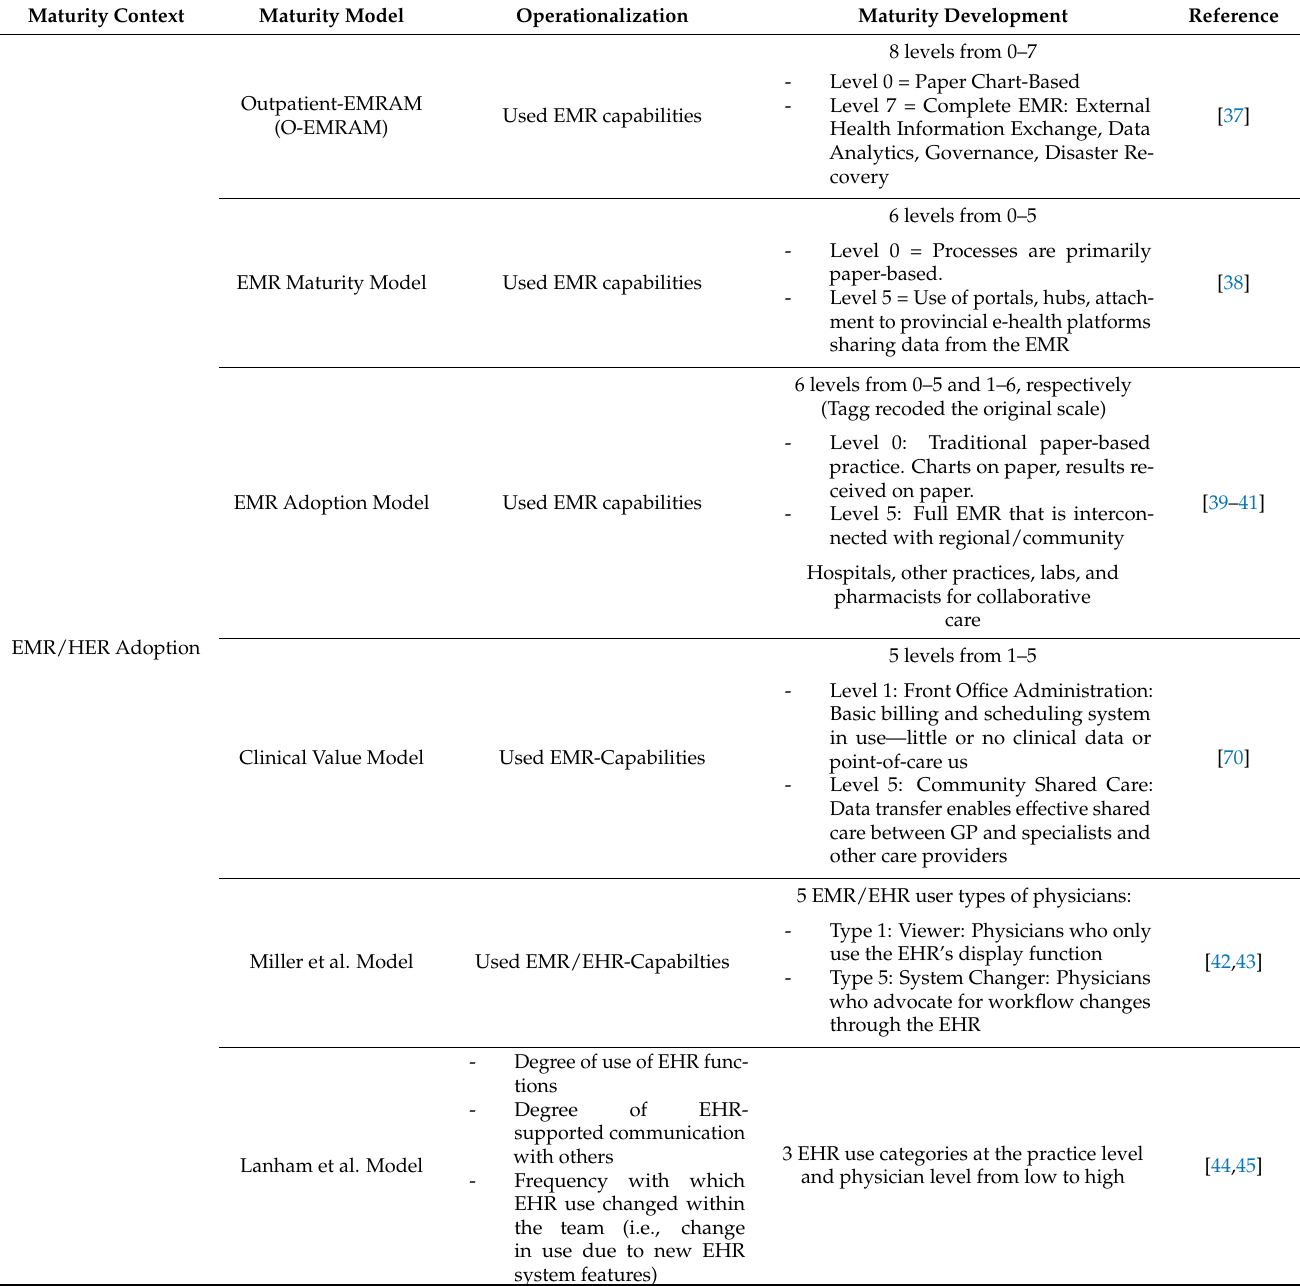
Table A1. Overview of the maturity measurements used.